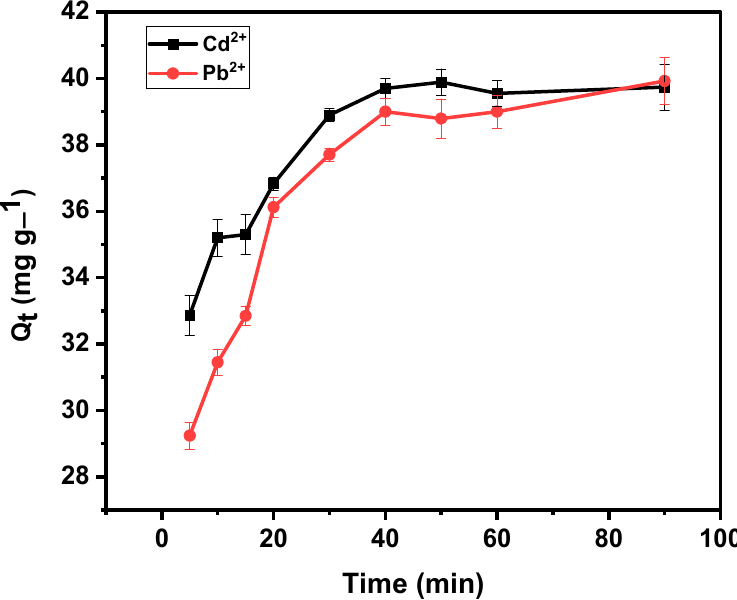
Figure 10. Adsorption capacity vs. time (min) on the adsorption of Cd 2+ and Pb 2+ using BPAC@Al 2 O 3 @chitosan material at an adsorbent mass of 0.1 g, pH of 6, and initial concentration of 20 mg L − 1 .